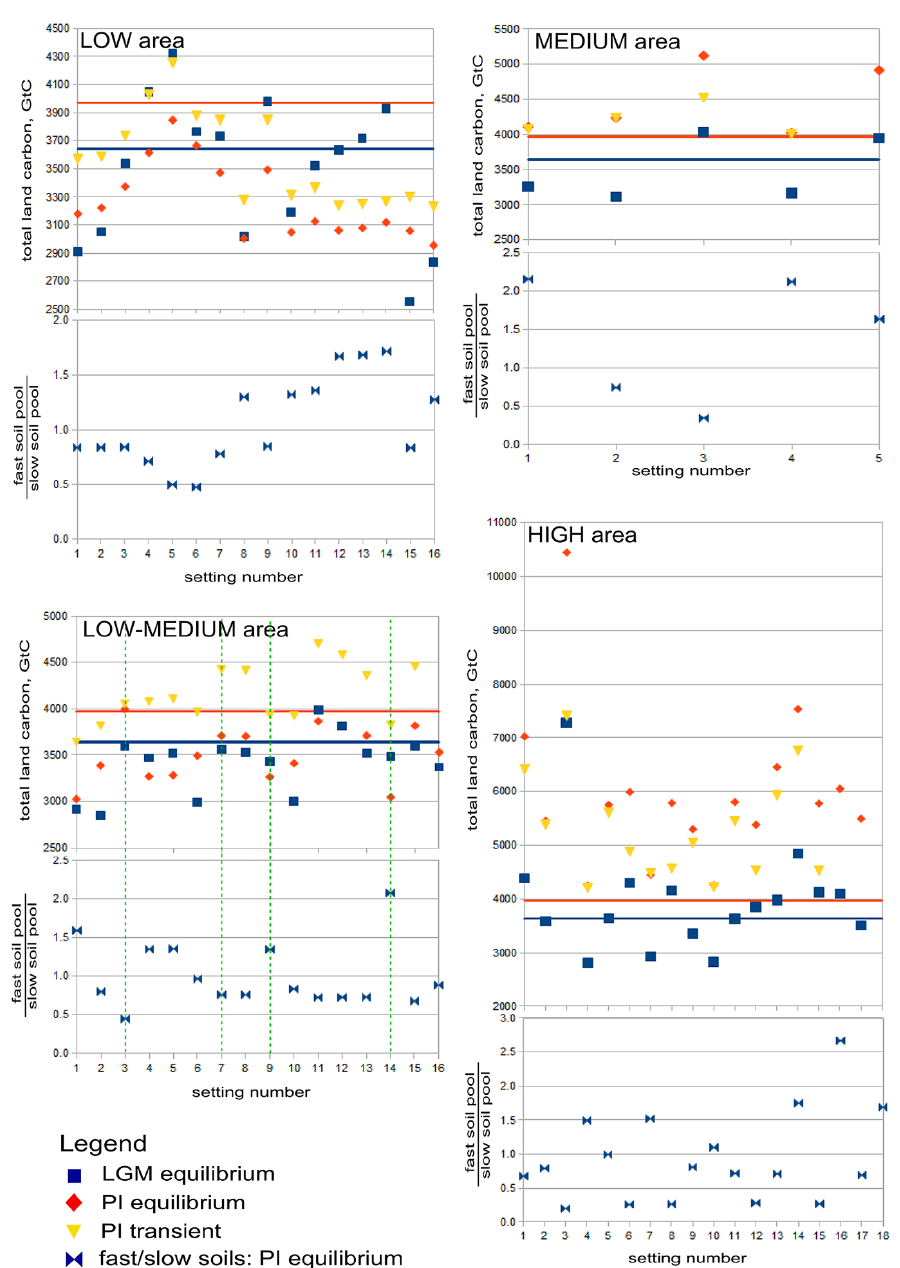
Figure C1. Modelled total land carbon stocks, and ratio of fast soils to slow soils for all settings used to tune the permafrost-carbon dynamics. Blue squares are for the LGM(eq) simulation, red diamonds are for the PI(eq) simulation and yellow triangles are for the PI(tr) simulation. Horizontal lines show the total land carbon estimates of Ciais et al. (2012). Green dashed lines indicate the chosen dynamic settings where LGM(eq) and PI(tr) show best agreement with Ciais et al. (2012)